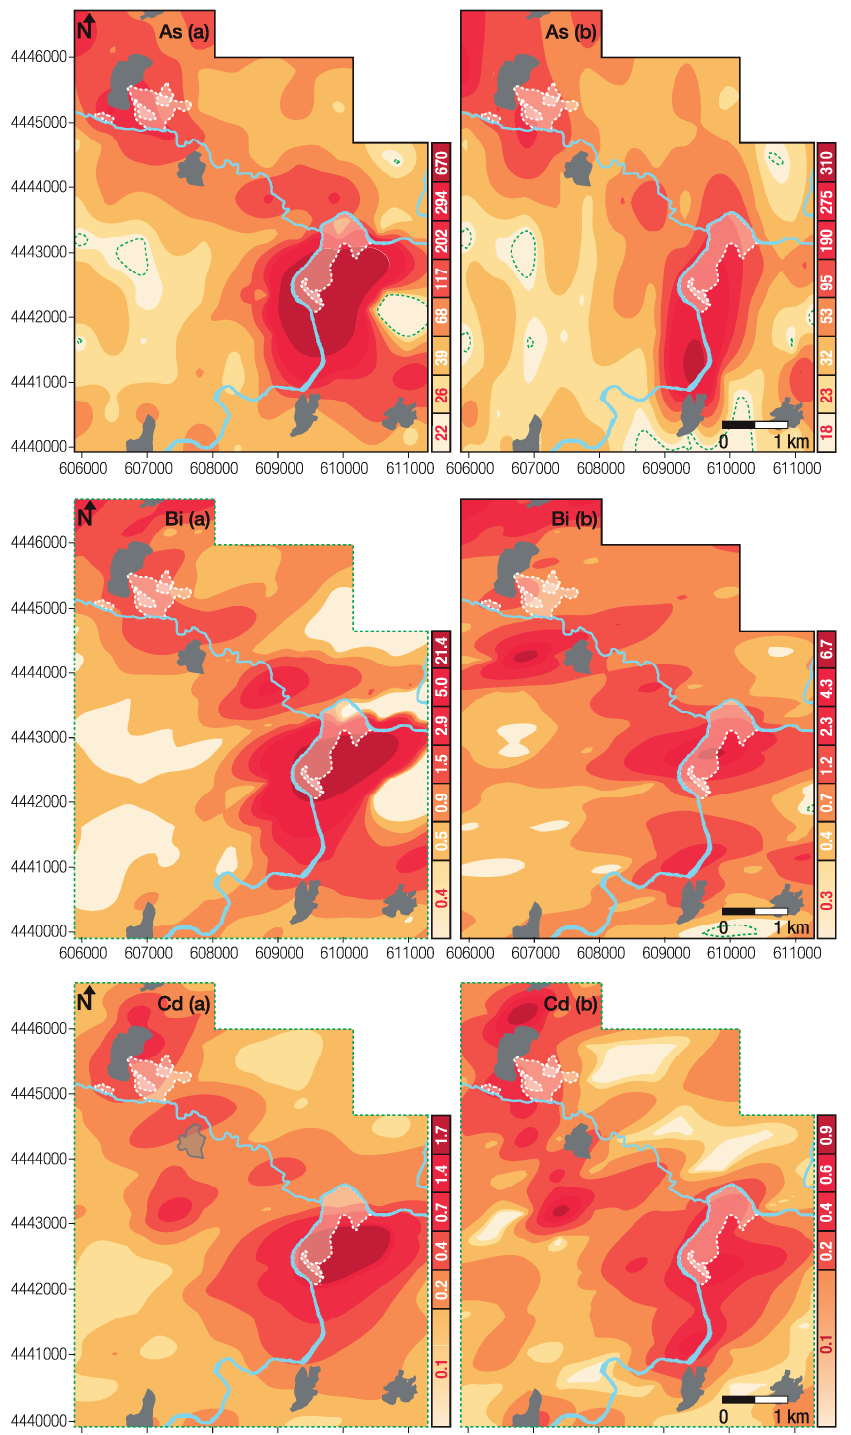
Figure 3. Spatial distribution of As, Bi, Cd (mg·kg − 1 ) values for topsoil ( a ) and subsoil ( b ). Percentile class limits at P5, P10, P25, P50, P75, P90, P95 and P97.5. The green dashed lines represent the elements background levels. In blue are represented the main water courses, in grey the villages and in white the main tailings and